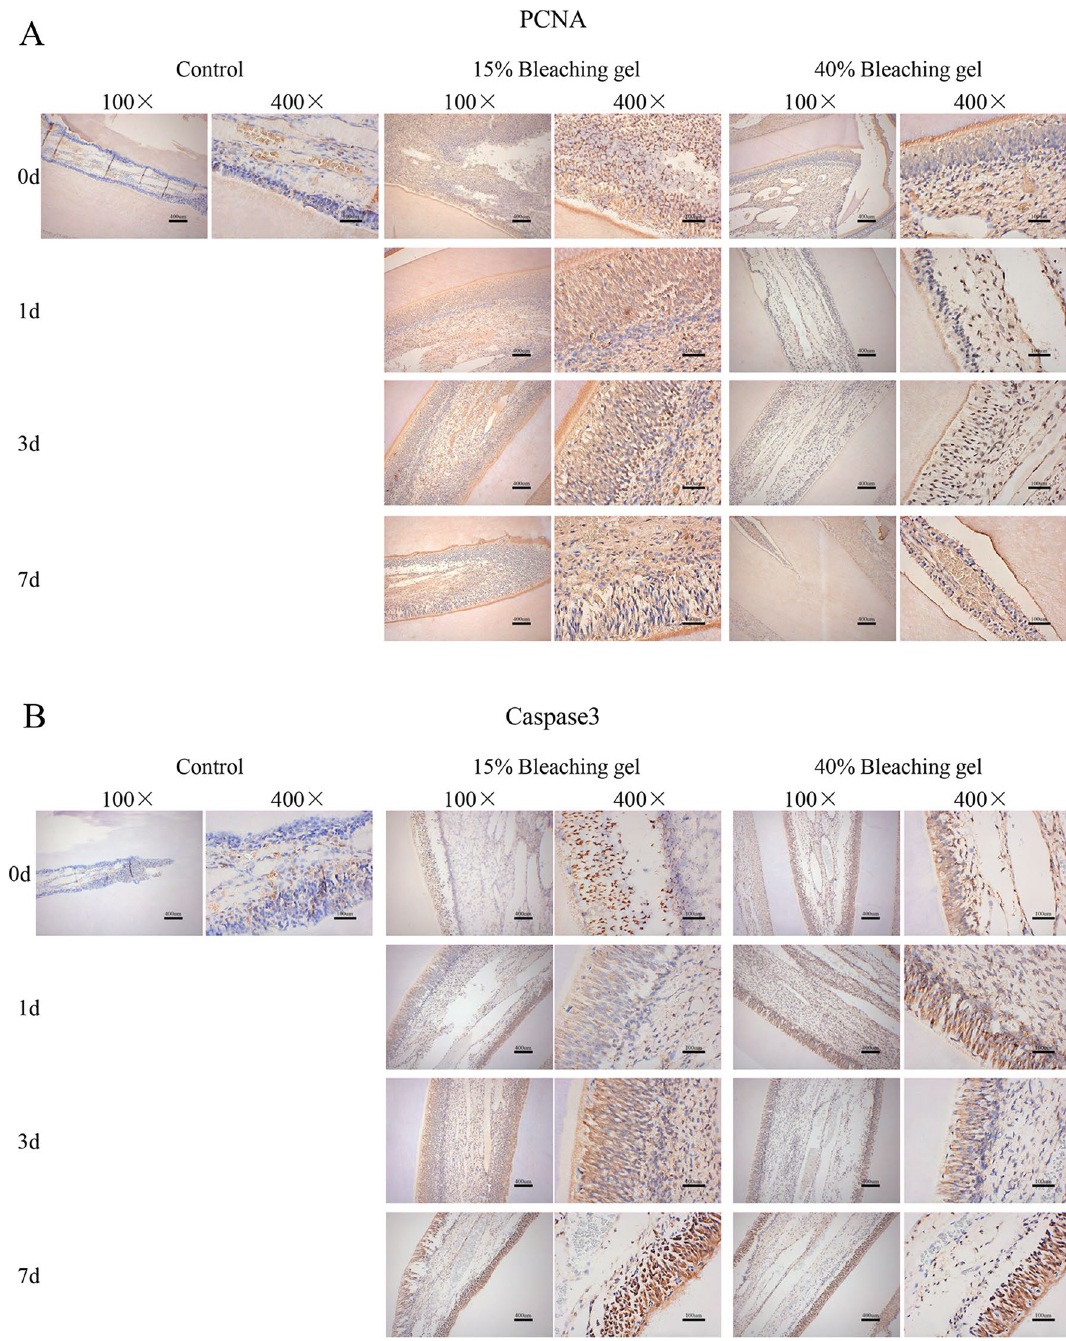
Figure 4. Changes in proliferation-related proteins after bleaching in a rat incisor model. Immunohistochemistry revealed the expression of proliferative factors, PCNA ( A ) and Caspase3 ( B ), in the incisor pulp of the rat. Bleaching significantly increased the expression of these factors in vivo, and the 15% gel demonstrated stronger enhancement. Bars = 400 μm in 100× magnification and 100 μm in 400× passage were used in the subsequent experiments as described previously 36 and cultured on the dentin surface of the disc. Informed consent was obtained from all participants in this study, and this study was performed in line with the principle of Declaration of Helsinki. Cell identification. Identification of stem cell surface markers. Trypsin (Beyotime) was used to detach the cells, which were then counted and aliquoted in eight Eppendorf tubes (1.5 mL, 1 × 10 5 cells/tube). One tube was used as a negative control group and only had phosphate buffered saline (PBS) containing 2% FBS added to it. Then, 100 μL of PBS containing flow cytometry antibody and 2% FBS was added to the other seven tubes, which